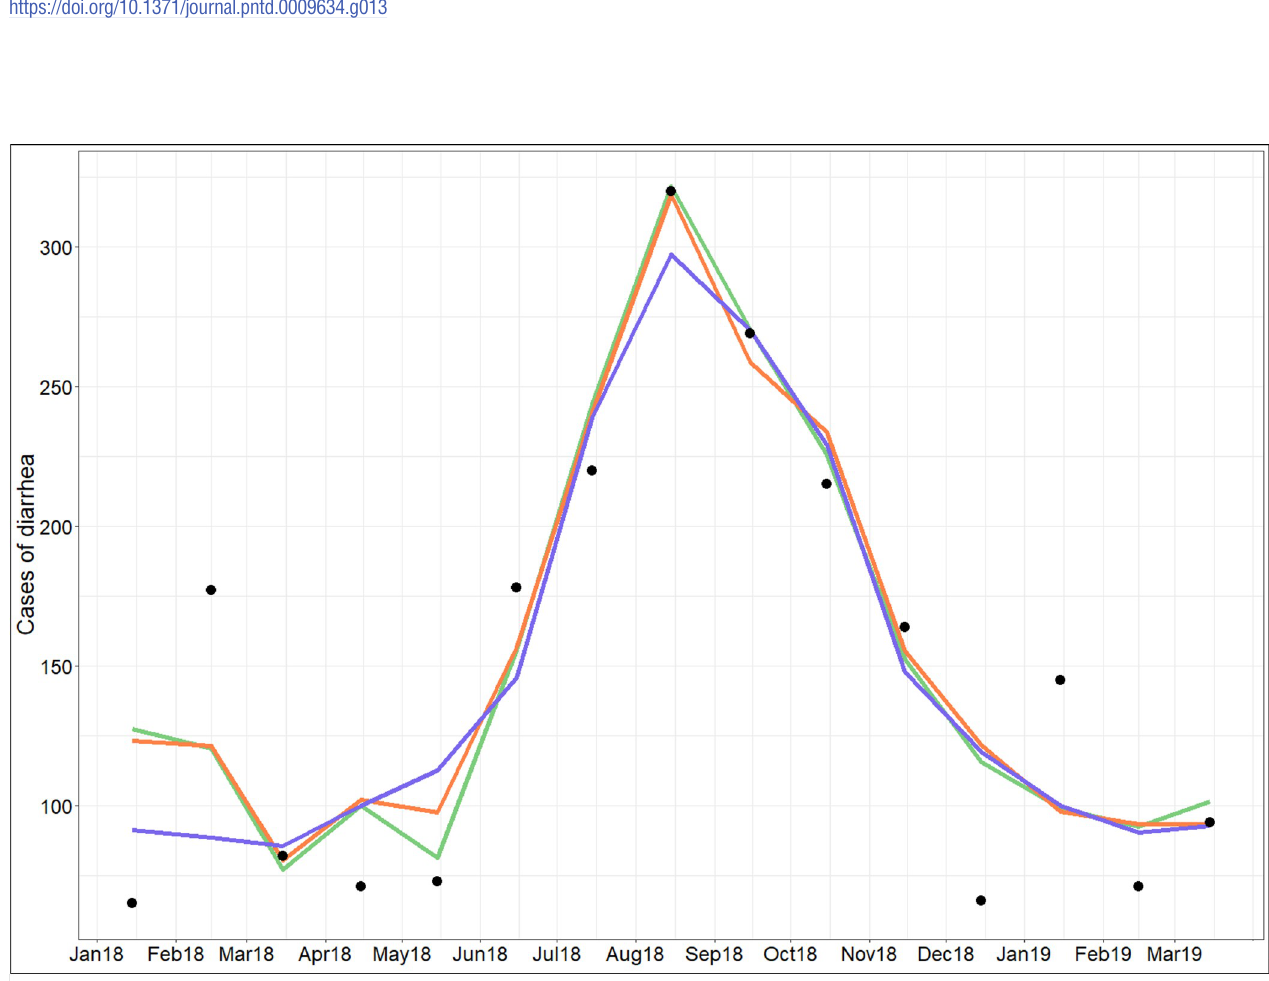
Fig 14. Observed diarrhea (black points) and predicted diarrhea cases using all variables (green line), NIR band, SPM, E.coli and rainfall variables (orange line) and only satellite variables (blue line).